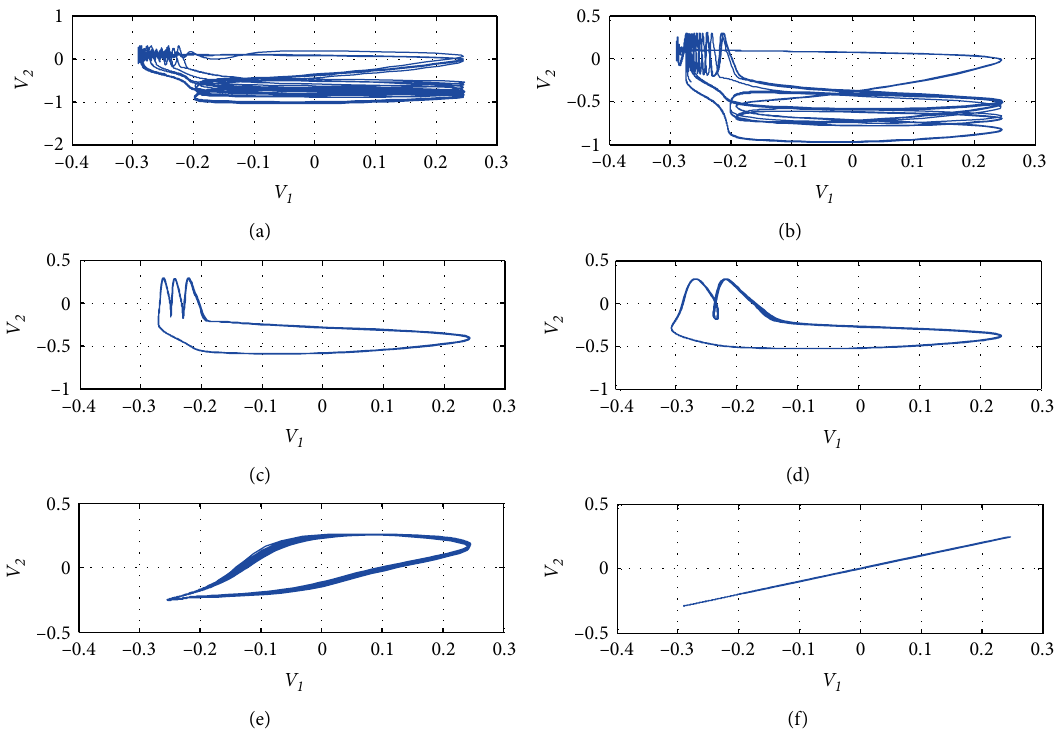
Figure 9: Phase diagrams of membrane potentials for two identical coupled neurons with different coupling intensity values. (a) 𝑔 𝑔 𝑠 = 0.004 , (c) 𝑔 𝑠 = 0.025 , (d) 𝑔 𝑠 = 0.09 , (e) 𝑔 𝑠 = 0.31 , and (f) 𝑔 𝑠 = 1.0 . Initial conditions are selected as (−0.1, 0, −2.5) and (−0.2, 0, −2.5) , respectively.